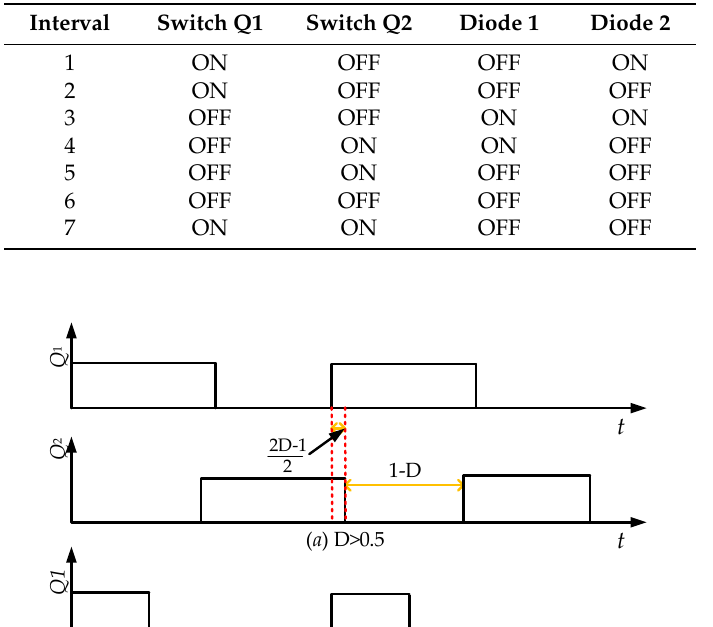
Table 1. Circuit steady-state operations.